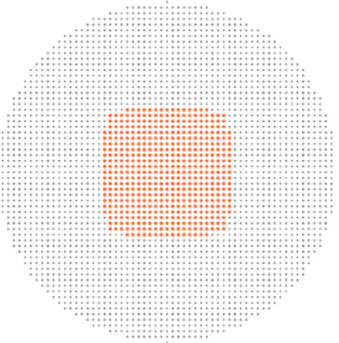
° , in which only about 1/6 of the total propagation modes are used.